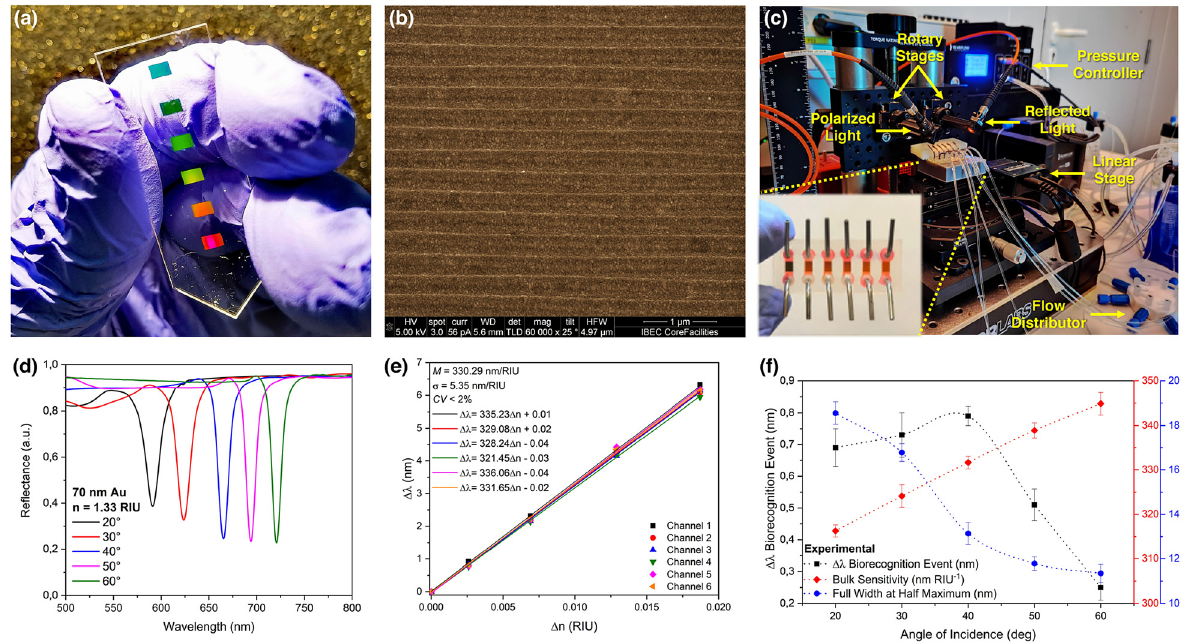
Figure 3: Fabrication and characterization of the multichannel 1D plasmonic nanocrystals-based biosensor. (a) Photography of a 70 nm Au evaporated Blu-Ray disc substrate and the characteristic diffraction of light. (b) SEM photograph of the fabricated plasmonic nanocrystals. (c) Experimental set-up including the optical detection scheme and the micro fl uidic system. The insert shows the multichannel integrated sensor. (d) Variation of the re fl ectance spectra in the water of the plasmonic nanocrystals under different lightincidenceangles.(e)Calibrationcurvesandbulksensitivityreproducibilitybetweenthesixchannelsfortheproposedplasmonicsensor. (f) In fl uence of the different incident angles of light in the sensing and biosensing performance of the plasmonic